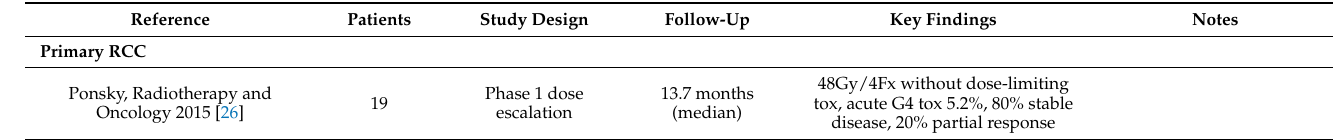
Table 1. Summary of key data supporting SAbR for RCC in various clinical